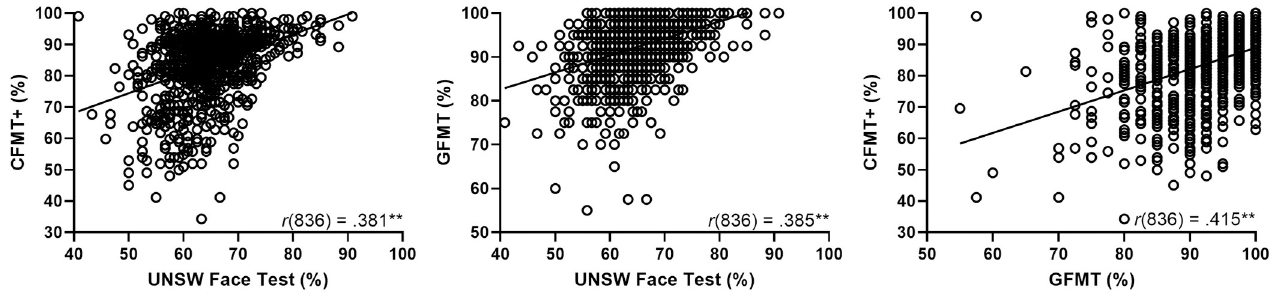
Fig 6. Scatterplots of the correlations between the UNSW face test, CFMT+ and GFMT for Online Sample 2. These results show the considerable variability in individual performance across the three tests, demonstrating the importance of repeated testing when establishing super-recognition. They also show that the UNSW Face Test does not suffer from ceiling effects, unlike existing tests and which can aid in the identification of super-recognisers. �� Significant at .01 level.